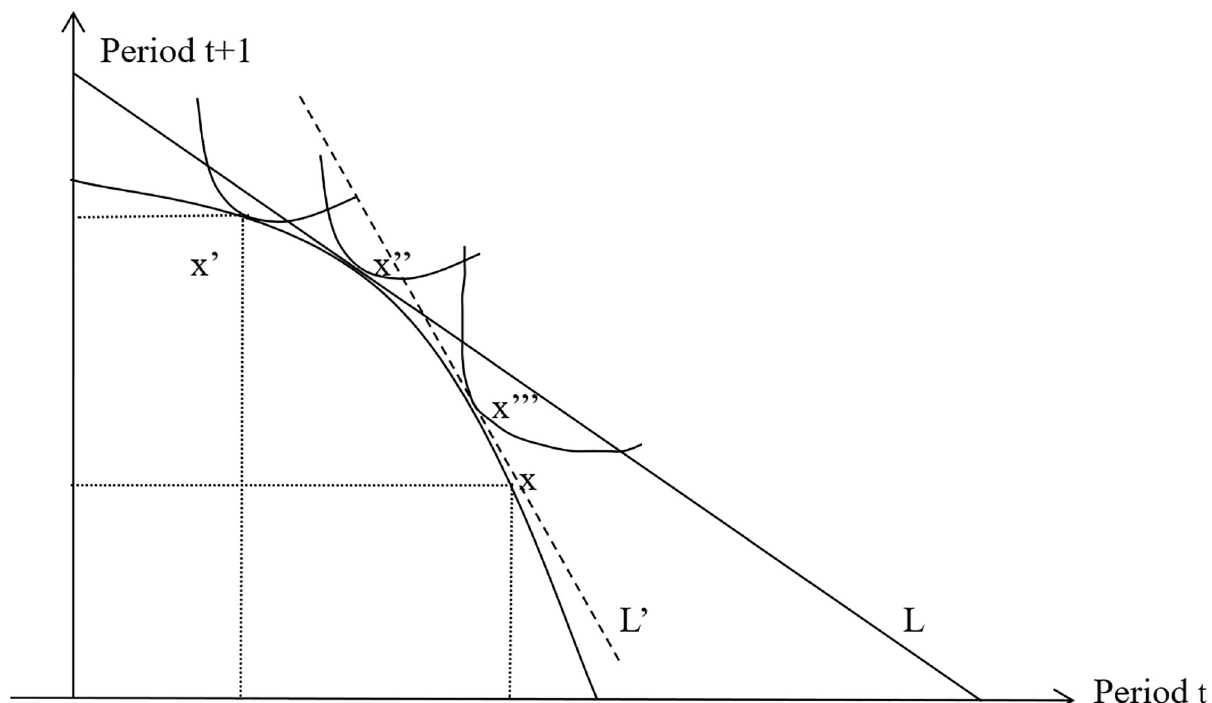
Fig 1. Digital finance enhancing the utility of relatively poor household X by promoting productive and financial investment. Note: Reconstructed by the author.